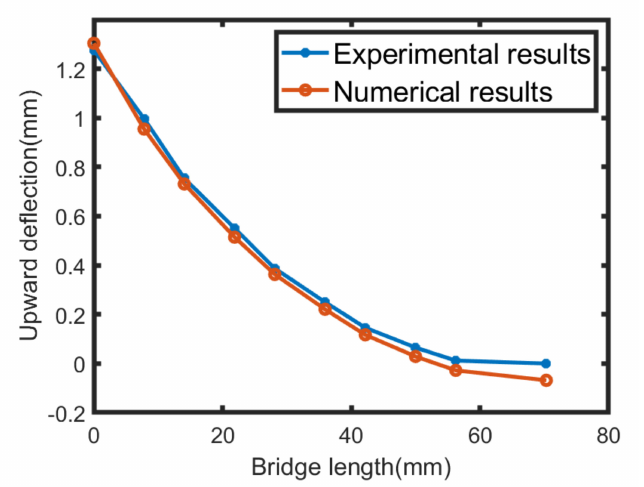
Figure 11. The NIST AMB2018-1 bridge geometry [9].